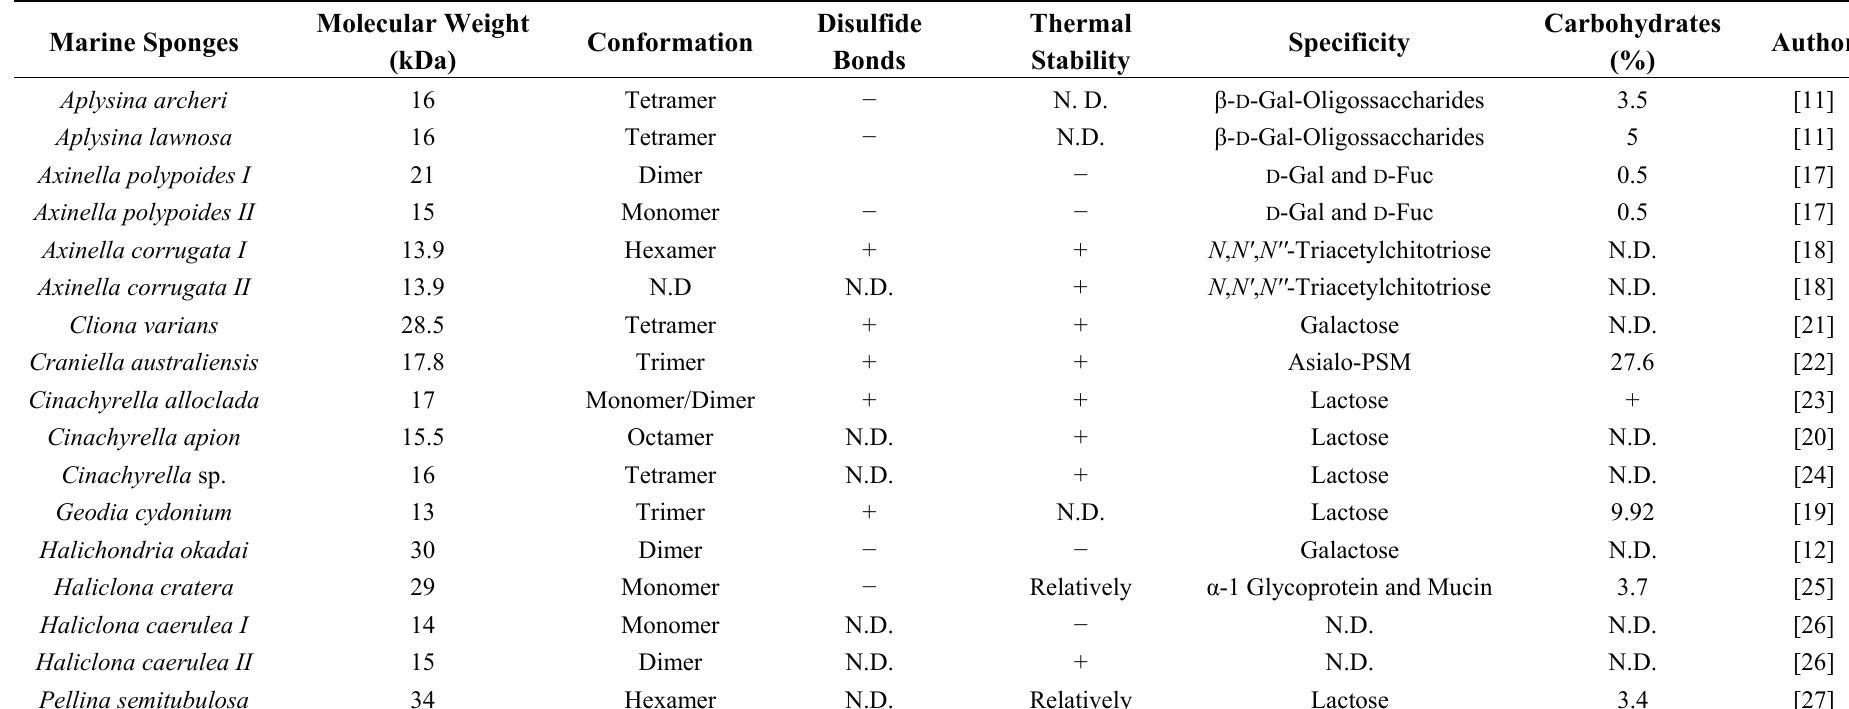
Table 1. Summary of the main characteristics of lectins from marine